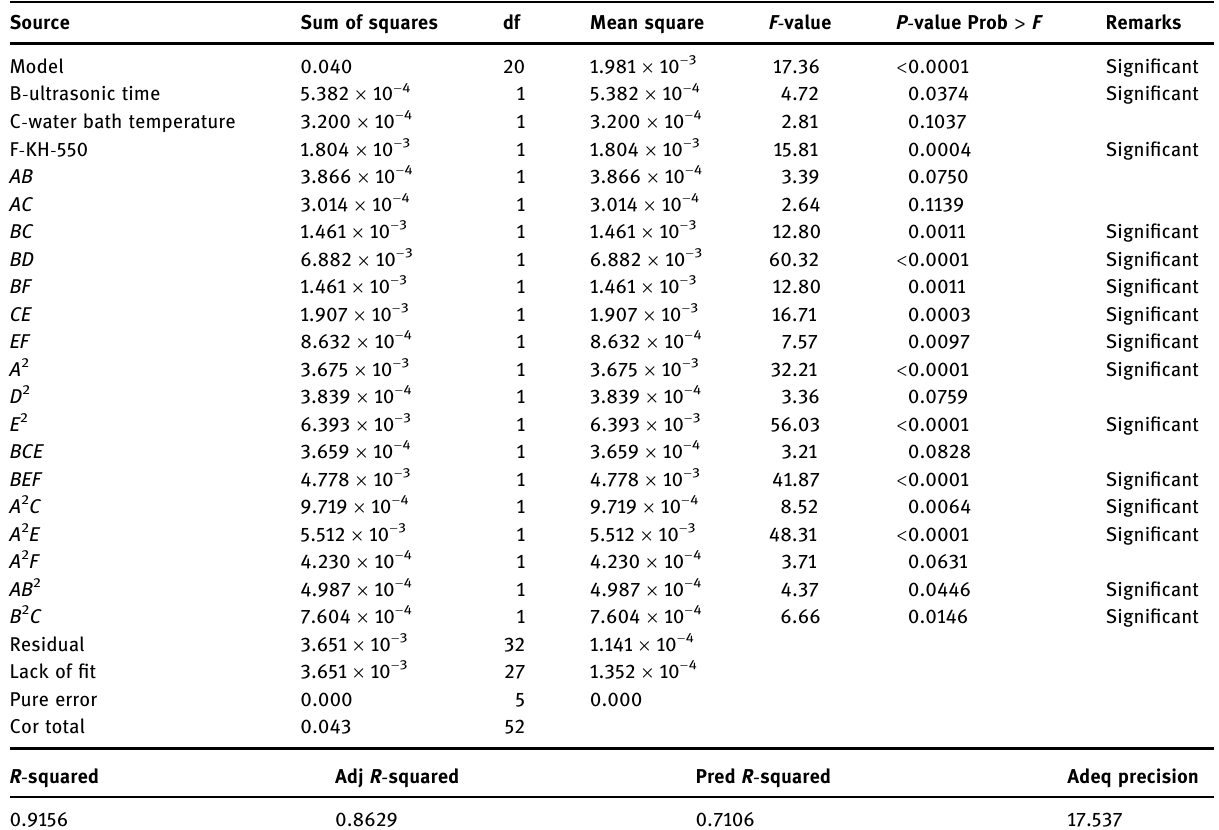
Table 4: Analysis of variance of adjusted response surface experiments